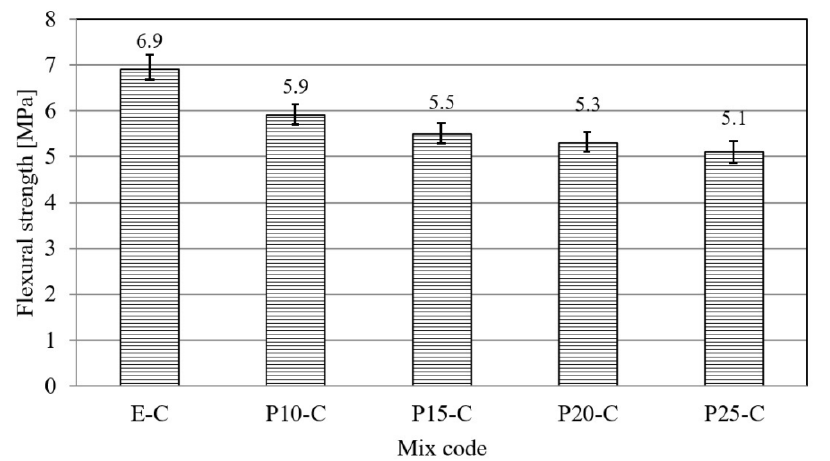
Figure 5. Flexural strength of concrete mixtures (28 days).